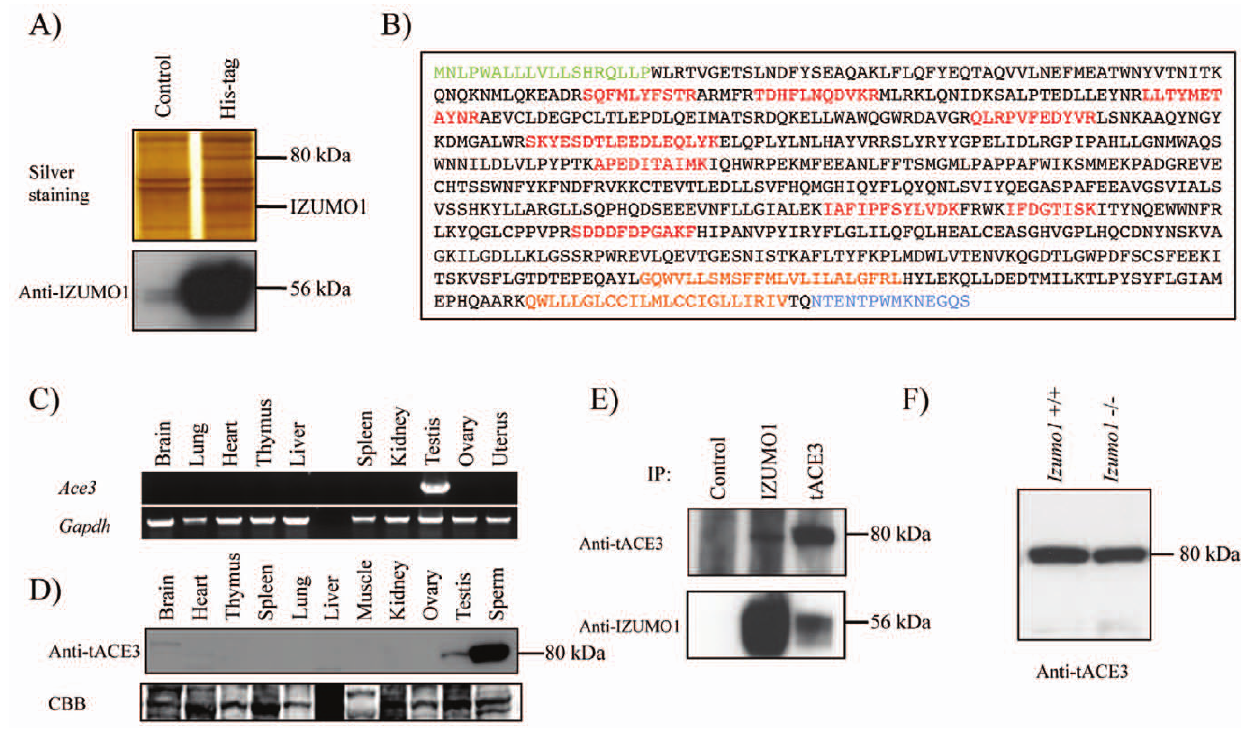
Figure 1. Identification and characterization of the IZUMO1-interacting protein. (A) The purified IZUMO1 protein complex was separated by SDS-PAGE and stained with silver. Two specific 80-kDa and 56-kDa bands appeared corresponding to tACE3 and IZUMO1, respectively. Proteins from wild-type sperm were used as controls. (B) Amino-acid sequences of mouse tACE3. The peptide sequences obtained by LC-MS/MS are shown in red. The putative signal peptide and transmembrane region are shown in green and orange, respectively. Antigen for producing tACE3-specific antibody is shown in blue. (C) Reverse transcription-PCR of Ace3 (upper panel) and Gapdh (control; lower panel) from 10 mouse cDNAs. (D) tACE3 was detected exclusively in testis and sperm by western blotting. All solubilized proteins were loaded at 30 m g on each lane and detected by 1 m g/ml anti-tACE3 antibody. (E) Interaction between IZUMO1 and tACE3. Total sperm proteins ( , 100 m g) prepared from wild-type male mice were immunoprecipitated with anti-IZUMO1 or anti-tACE3 antibodies and blotted with anti-tACE3 or anti-IZUMO1 antibodies, respectively. (F) tACE3 protein exists in Izumo1 -deficient sperm.